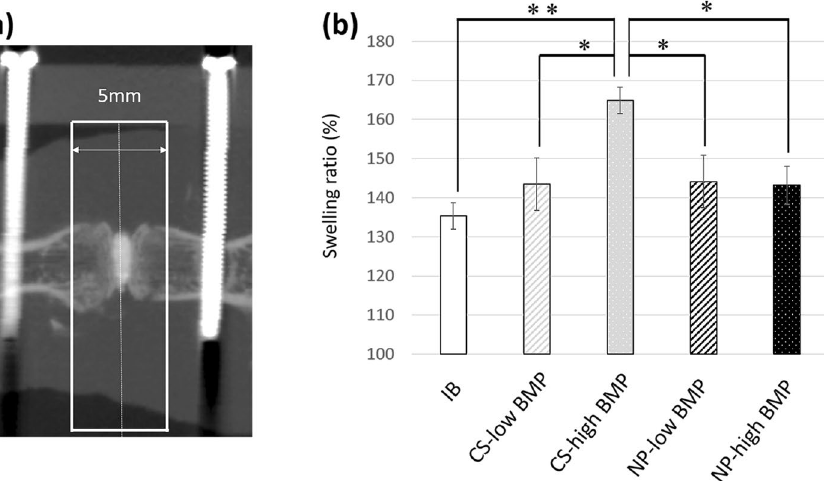
Figure 4. Quantification of surgical site swelling. ( a ) Region of interest for measurement of tissue volume. The dotted line denotes the middle of the intervertebral disc space. ( b ) Comparison of the swelling ratio among groups. The swelling ratio in the CS-high group was significantly greater than that in the other groups. *, p < 0.05; **, p <